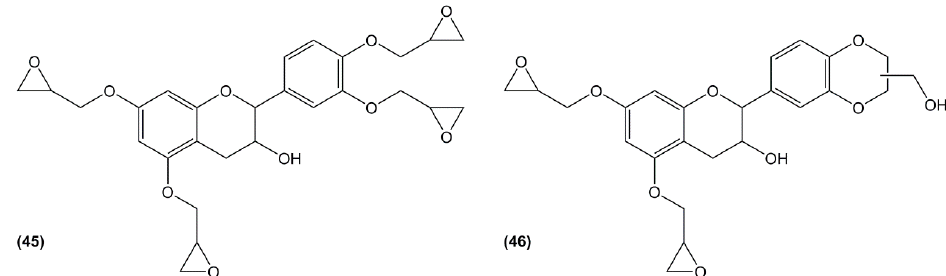
Figure 27. Epoxy monomers obtained by glycidylation of catechin according to Nouailhas et al. [128].